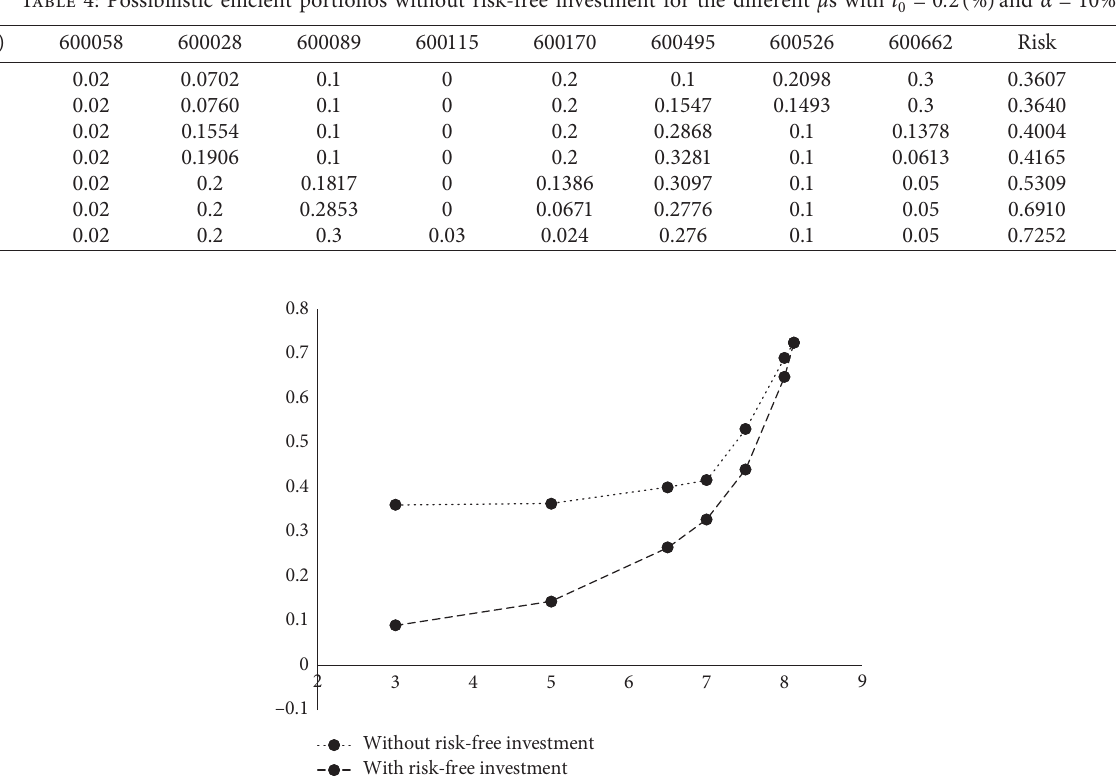
Figure 1: Variation of portfolio risks with μ .